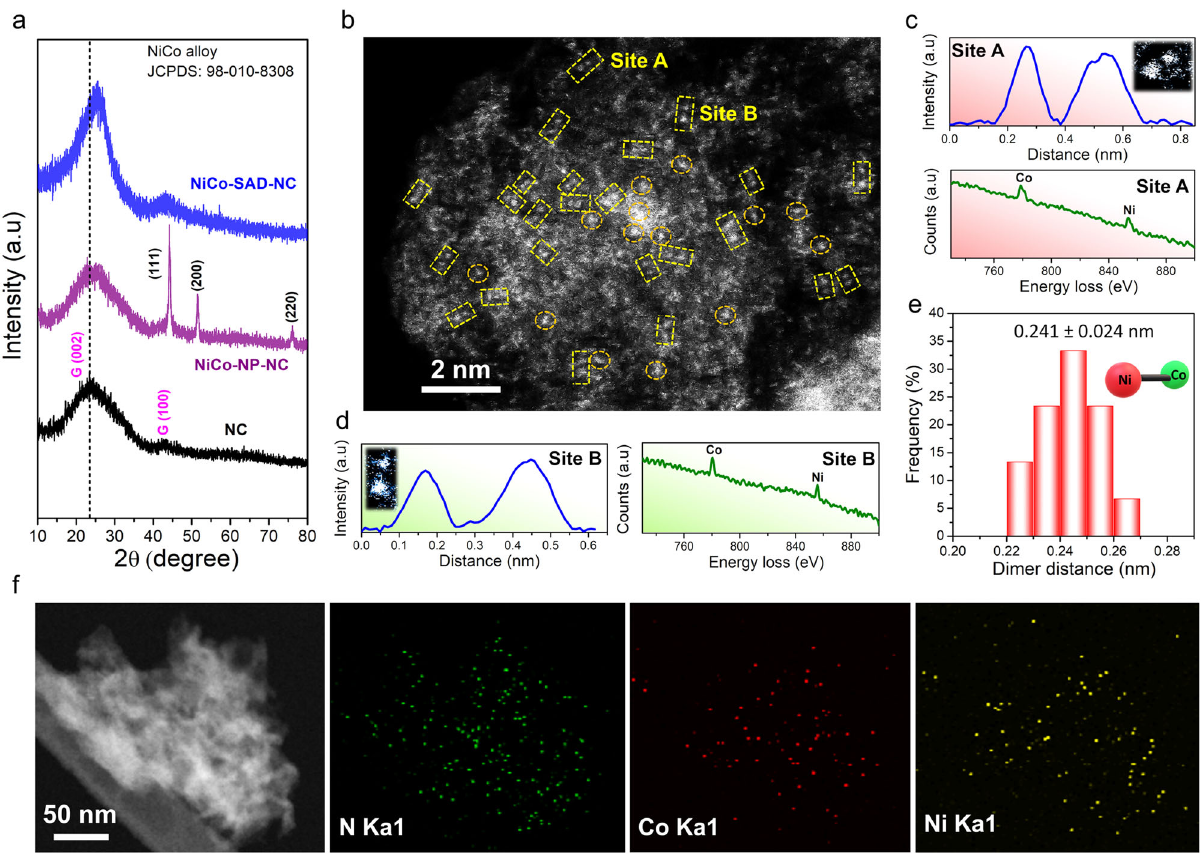
Fig. 3 Structural analysis and electron microscopy of NiCo-SAD-NC. a XRD spectra of NC, NiCo-NP-NC, and NiCo-SAD-NC. b Aberration-corrected HAADF-STEM image of the NiCo-SAD-NC. The yellow squares in b shows the dimer sites and some of single Ni/Co atom sites are highlighted by orange circles. c , d The intensity pro fi le and corresponding EEL spectra obtained at site A ( c ) and site B ( d ) for NiCo-SAD-NC indicate Ni and Co are coordinated at the atomic scale. e Statistical Ni-Co distance in the observed dimers. f HAADF-STEM image and corresponding EDS maps of NiCo-SAD-NC showing the uniform dispersion of N (green), Co (red), and Ni